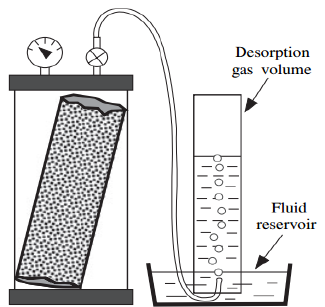
Figure 2. Schematic of a Manual Measuring Cylinder.